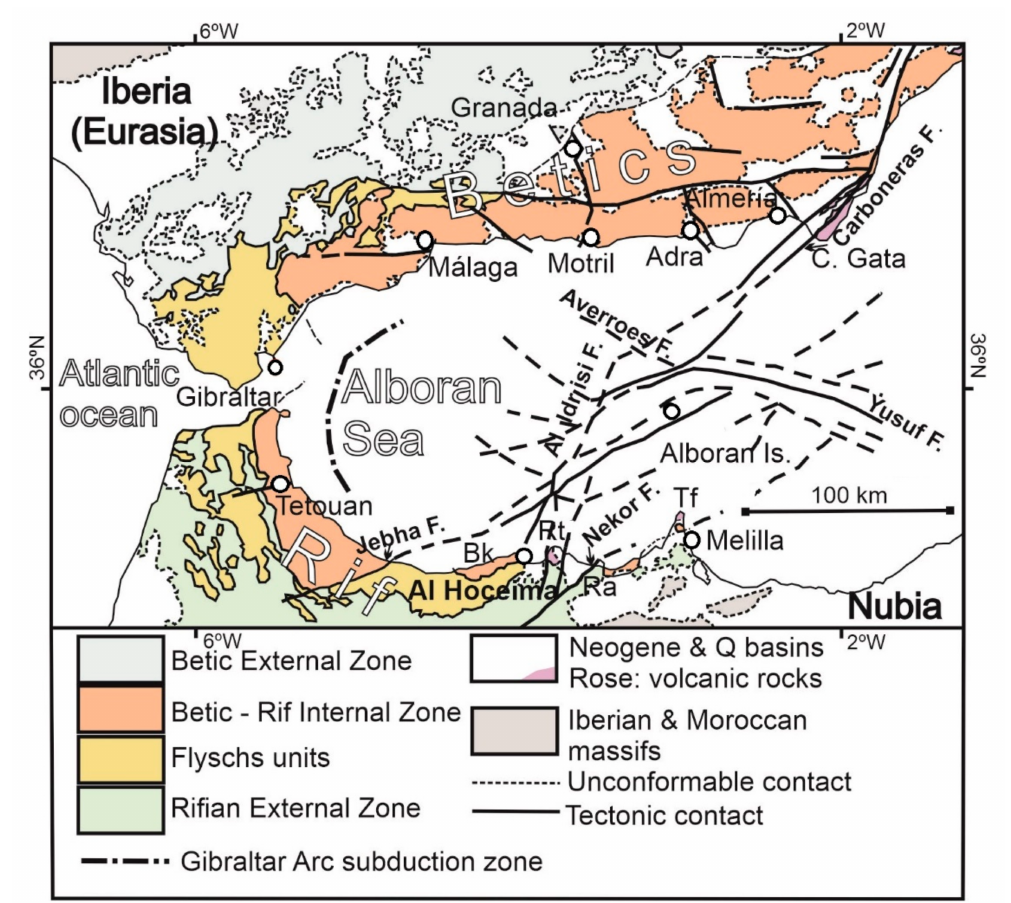
Figure 1. Geologic sketch map of the Betic-Rif region and location of the Al Hoceima study area. Bk: Bokoya Massif; Ra: Ras Afrou; Rt: Tas Tarf; Tf: Tres Forcas Cape. Internal Zone includes Sebtides and Ghomarides in the Rif and Nevado-Filabrides, Alpujarrides and Malaguides in the